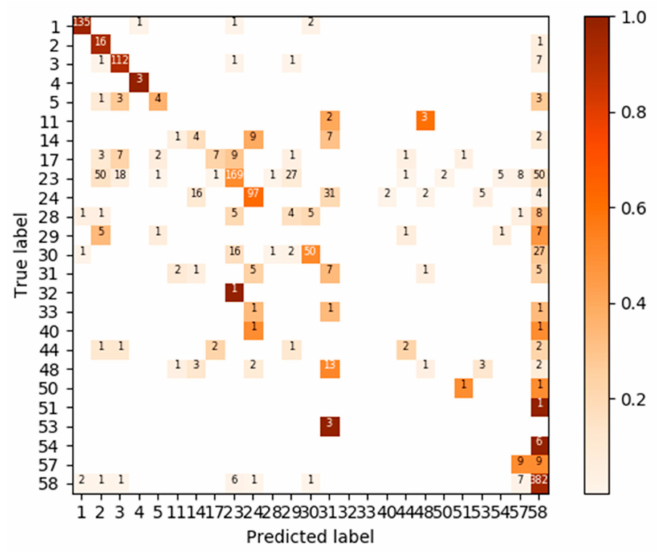
Figure 9. Classification result of the test using inventory tuning. The vertical axis is the ground truth and the horizontal axis is the model prediction. The number in each cell indicates the number of classified images; each cell is colored according to the percentage of the number of images in each class. The Kappa score is 0.62.